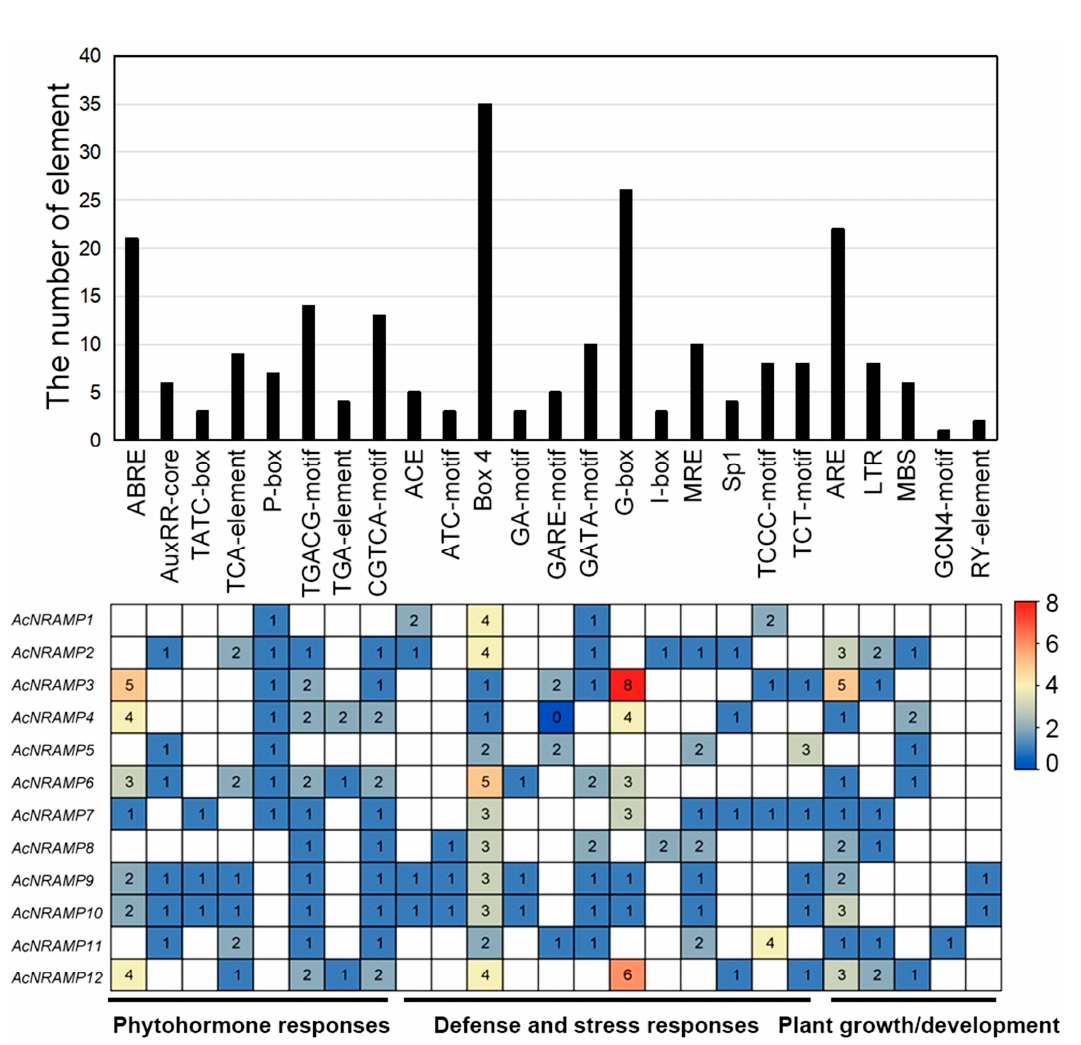
Figure 6. Cis-acting elements of AcNRAMPs . The bar chart represents the total number of cis-acting elements within each AcNRAMP. The heatmap shows the number distribution of different cis-acting elements within each AcNRAMP.